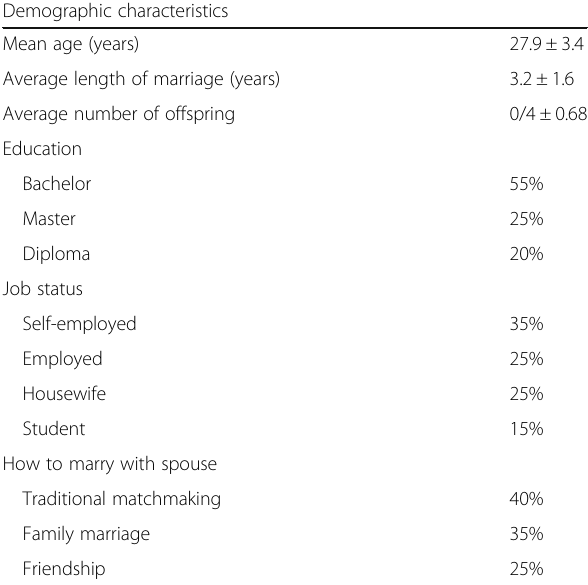
Table 1 Demographic characteristics of participants ( n = 43) Demographic